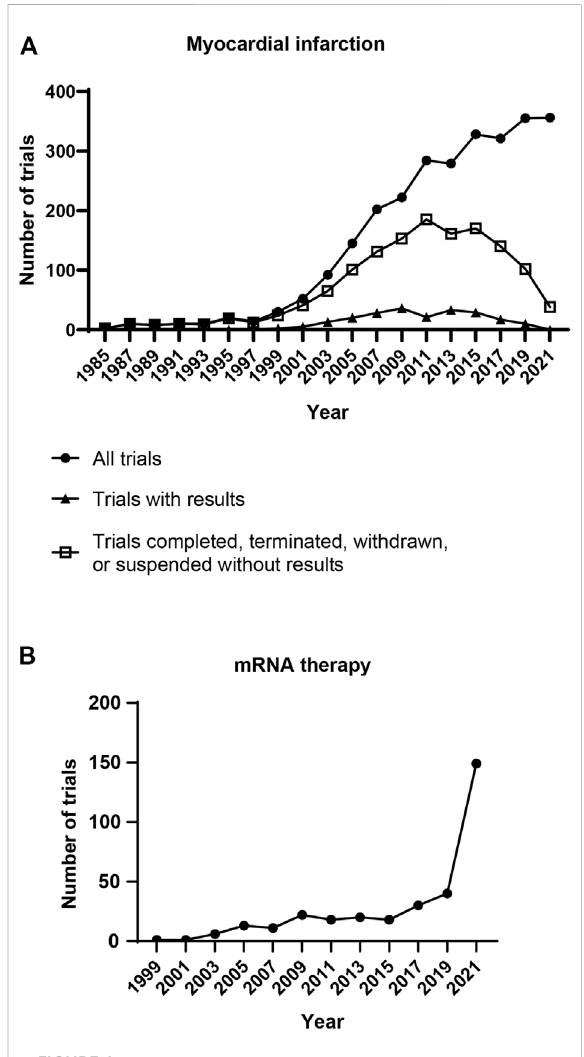
FIGURE 1 Clinical trials related to mRNA therapy and myocardial infarction. (A) Number of clinical trials for myocardial infarction. Each dot represents the clinical trials initiated in the